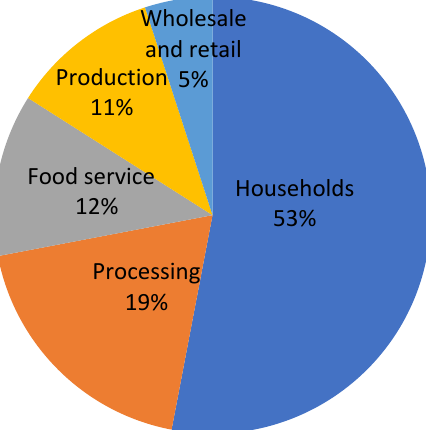
Figure 3. Food waste by individual actors in the supply chain in the countries of the EU in 2012. Source: created by authors according to data [62].